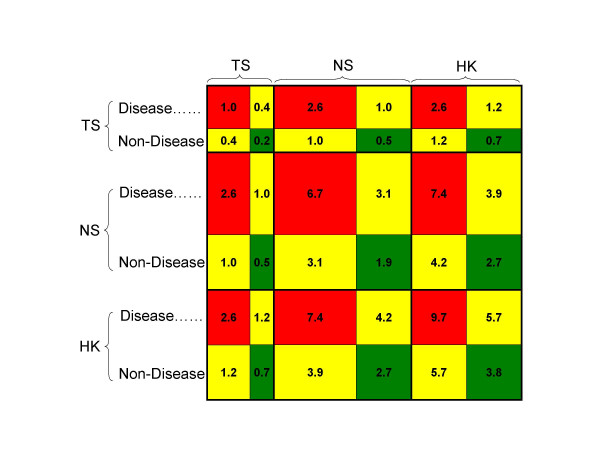
Relating gene connectivity with disease association and tissue specificity. Percentage of gene-gene interactions that exists between two groups of genes depending on their tissue specificity (TS: tissue-specific, NS: non-specific, and HK: housekeeping) and disease association. Colours indicate interactions between two disease-associated genes (red), between a disease-associated and a non-disease-associated gene (yellow), and between two non-disease-associated genes (green). The size of the rectangles indicates the relative number of interacting genes in each group.